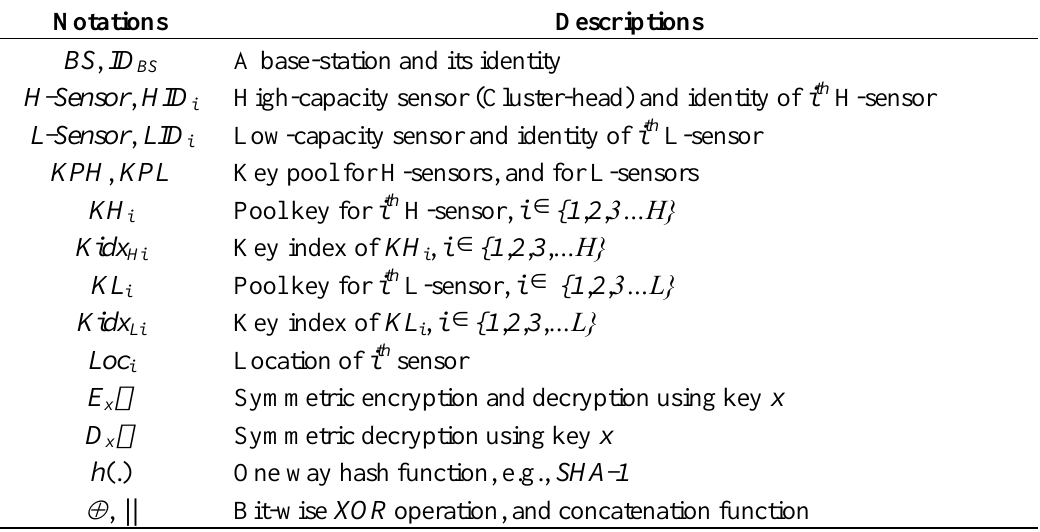
Table 1. Notations and